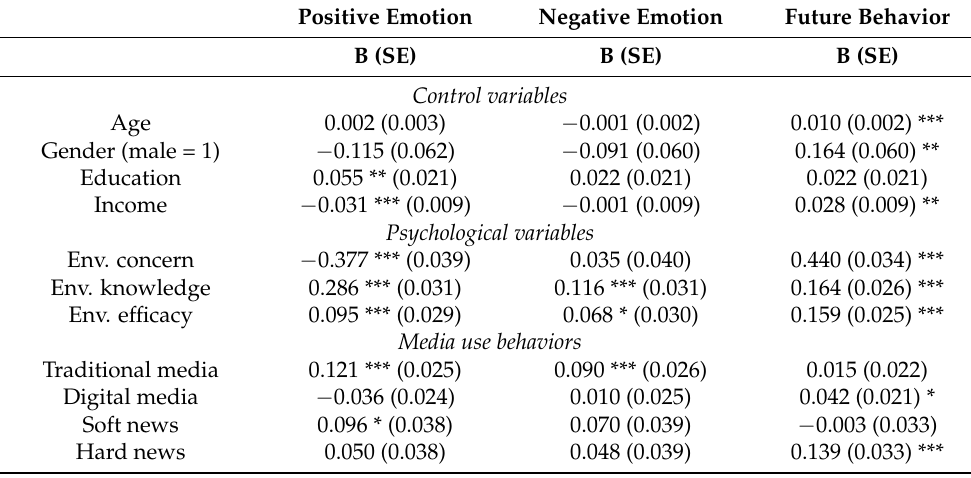
Table 5. Predictors of emotional responses and future behavioral